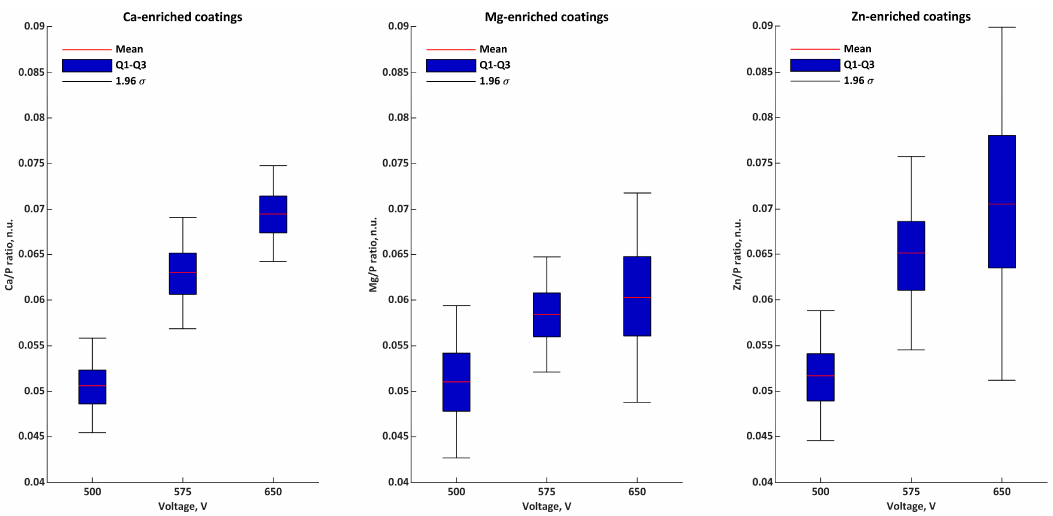
Figure 2. Atomic ratios (EDS) of coatings formed in Electrolyte 1.